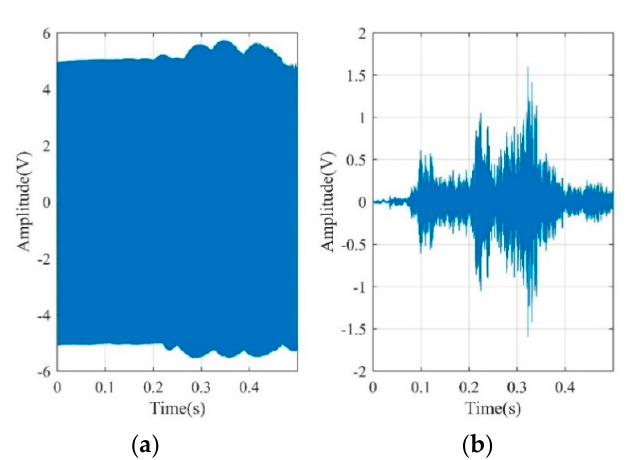
Figure 2. ( a ) Signal emitted by the DAQ; ( b ) signal received by the receiver PZT transducer.